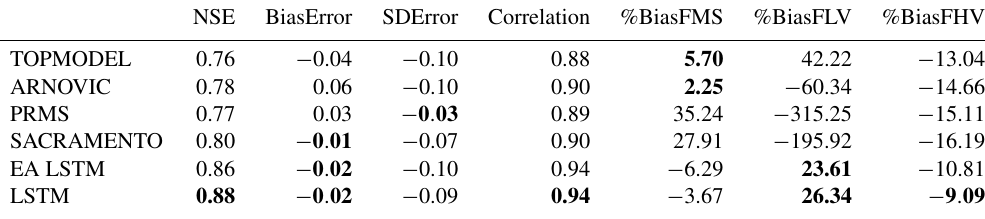
Table 3. Summary of all goodness-of-fit metrics used to benchmark performance against the conceptual models for the validation period 1998–2008 on the 518 stations found in both CAMELS-GB data (Coxon et al., 2020a) and the FUSE conceptual models (Lane et al., 2019). We have shown the median catchment score for the metric given the mean simulated discharge of our ensemble. Values that are not significantly different from the best model are highlighted in bold ( α = 0 .